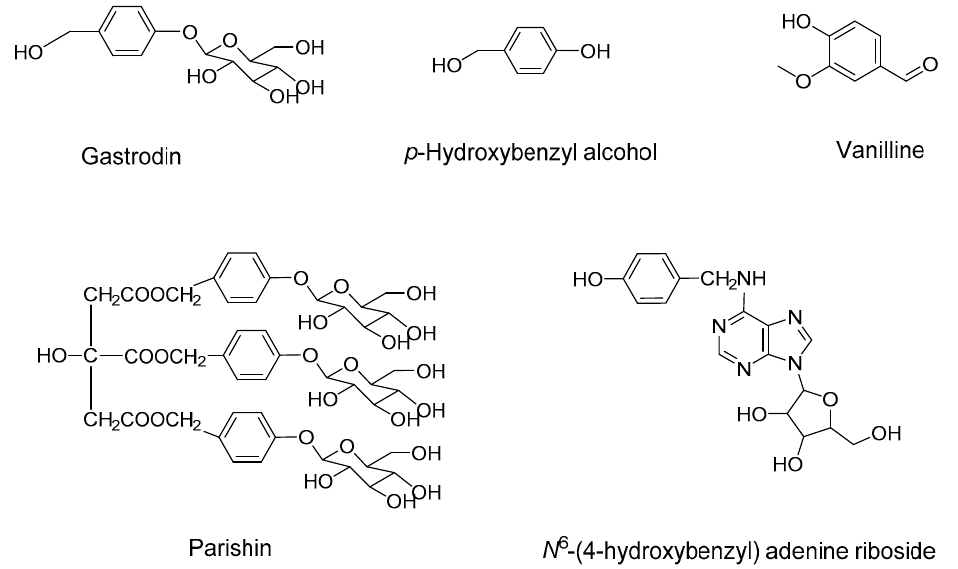
Figure 1. The structures of main bioactive constituents from G. elata .